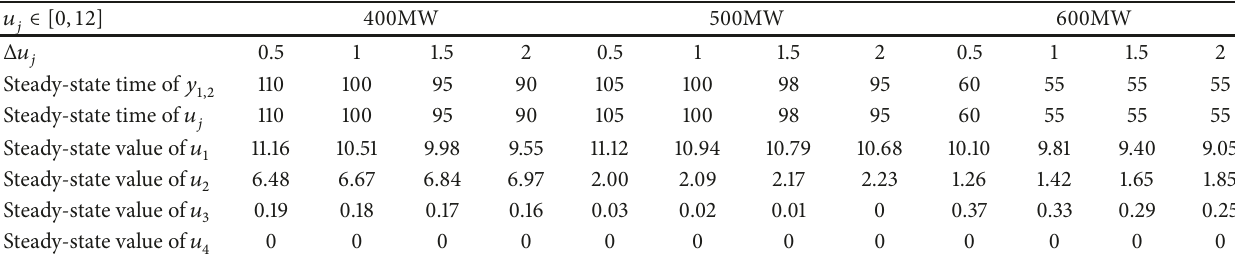
Table 5: Steady-state values of 𝑢 𝑗 when 𝑢 𝑗 ∈ [0, 12] .